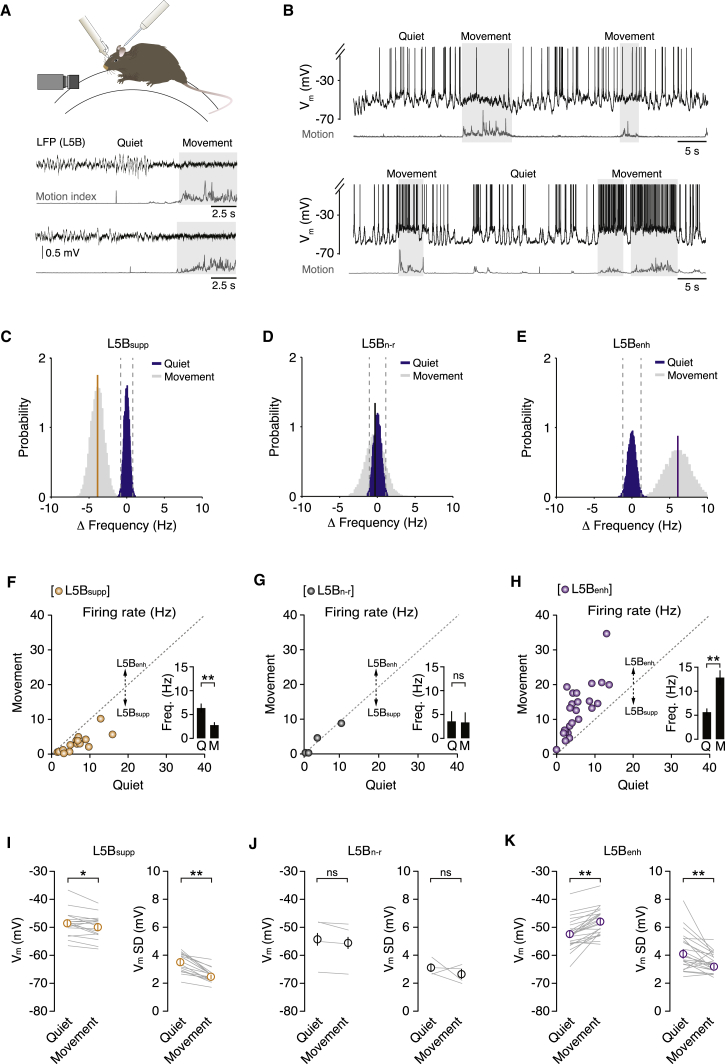
Membrane Potential Dynamics of L5B Pyramidal Neurons in M1 during Self-Paced, Voluntary Movement(A) Patch-clamp recording configuration in head-fixed mice mounted on a single-axis, cylindrical treadmill. Local field potential (LFP) recordings (black traces, n = 2 mice) of L5B activity and moderate speed (60 frames/s) digital imaging were used to confirm changes in behavioral state (quiet wakefulness to movement) and to calculate motion index (gray traces).(B) Representative voltage traces from two L5B pyramidal neurons that displayed either a decrease (top) or increase (bottom) in firing rate during movement (light gray shading). The motion index (dark gray) defines the magnitude and duration of each forelimb movement. In this figure and all subsequent figures, action potentials have been truncated to highlight subthreshold Vm changes during movement.(C–E) Representative change in firing rate probability distributions during quiet wakefulness (blue) and movement (gray) in L5Bsuppressed (C), L5Bnon-responding (D), and L5Benhanced (E) neurons. Gray dotted lines represent the 1st (left) and 99th (right) percentiles. Solid colored lines represent the average firing rate change in L5Bsuppressed (yellow), L5Bnon-responding (black), and L5Benhanced (purple) neurons during movement.(F–H) Average firing rate during quiet wakefulness and movement in L5Bsuppressed (F, n = 17), L5Bnon-responding (G, n = 4), and L5Benhanced (H, n = 24) neurons. Filled circles represent data from individual neurons. Insets depict the average firing rate ± SEM during quiet wakefulness (Q) and movement (M). ∗∗p < 0.01; ns, non-significant.(I–K) Average Vm (left-hand plot) and Vm SD (right-hand plot) in L5Bsuppressed (I, n = 17), L5Bnon-responding (J, n = 4), and L5Benhanced (K, n = 24) neurons during quiet wakefulness and movement. Solid gray lines represent data from individual neurons while open symbols represent mean ± SEM. ∗p < 0.05, ∗∗p < 0.01; ns, non-significant.See also Figures S1–S4 and Tables S1 and S2.